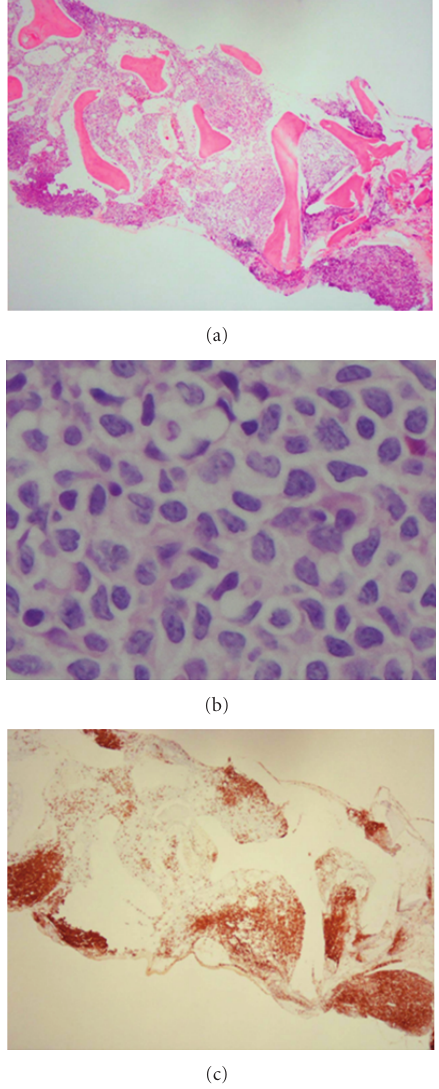
Figure 1: Images of the bone marrow biopsy showing the involvement of large abnormal lymphoid cells with focal clusters. (a) Hematoxylin-eosin staining, low-power field ( × 40); (b) hema- toxylin-eosin staining, high-power field ( × 1,000); (c) the tumor cells were positive for CD20.